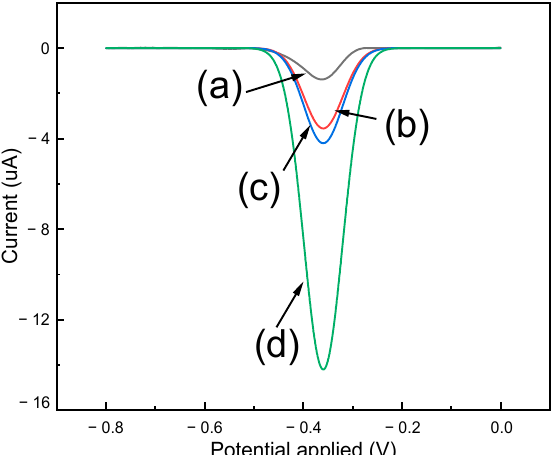
Figure 3. Differential pulse voltammograms obtained for ( a ) GCE, ( b ) MWCNT/GCE, ( c ) NIP/MWCNT/GCE, and ( d ) MIP/MWCNT/GCE applied in PBS (at pH 3) in the presence of 100 μ mol L − 1 methotrexate.